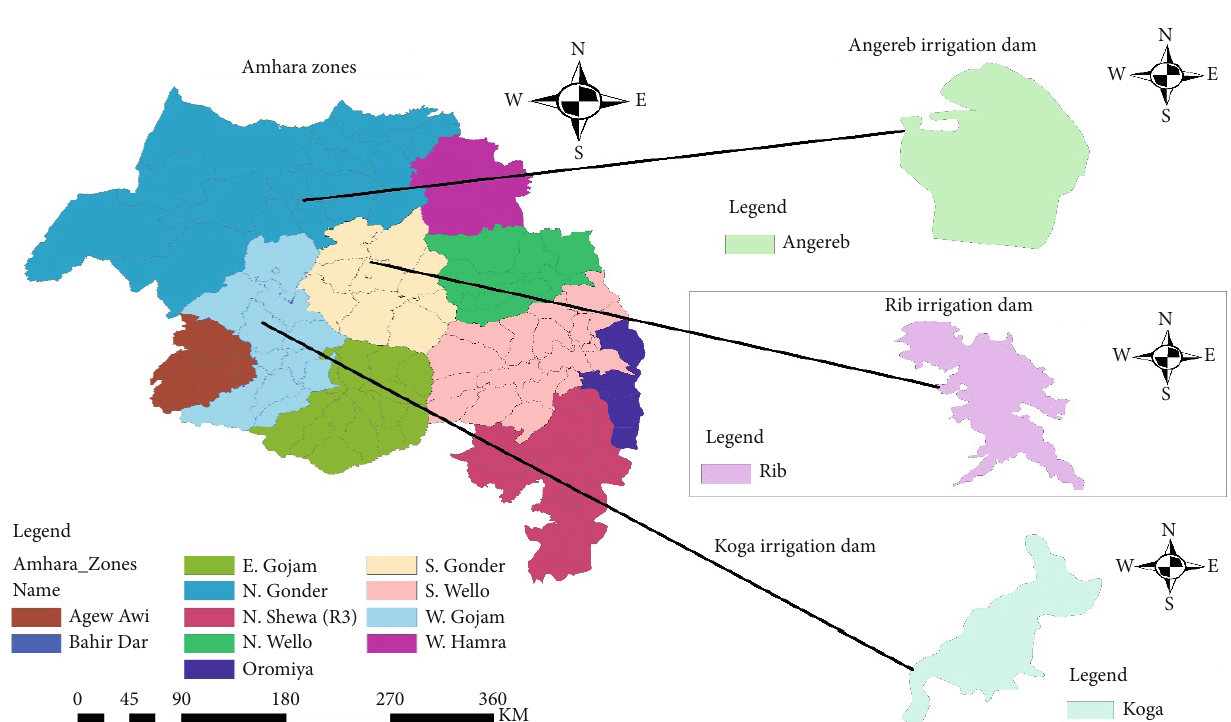
Figure 1: Map of Amhara Region and the irrigation